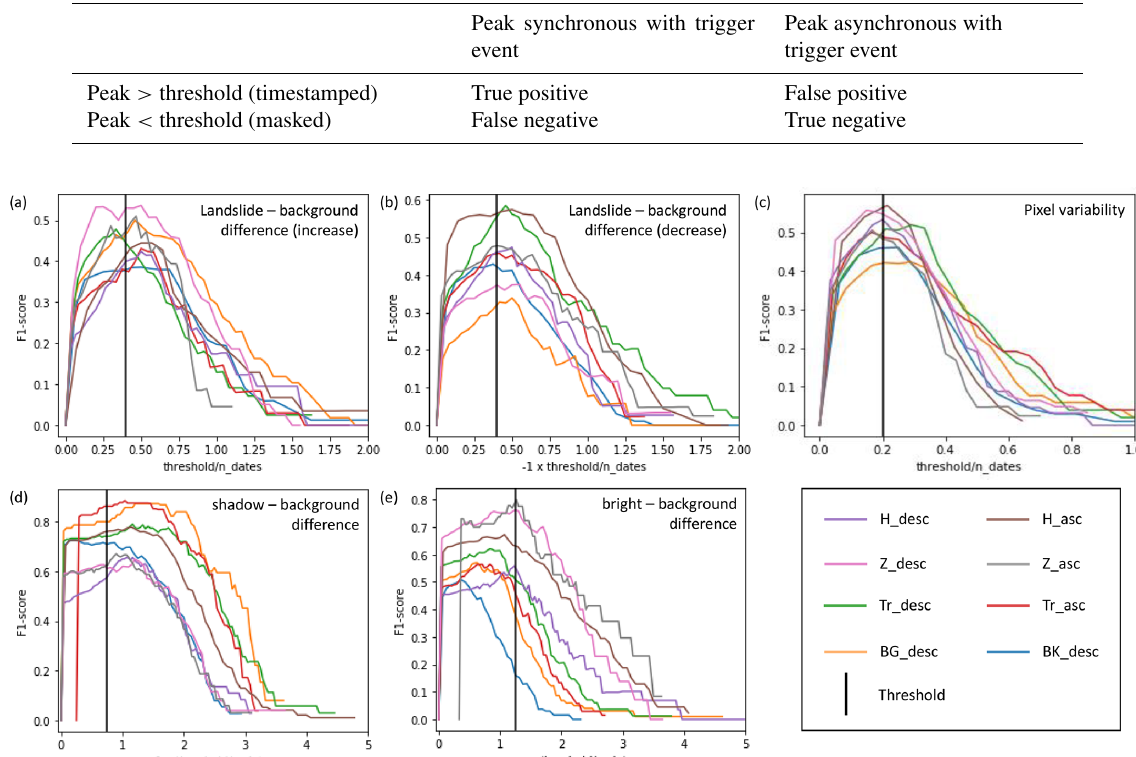
Table 1. Confusion matrix for determining how convolution peak size relates to whether a landslide timing is likely to be correct.